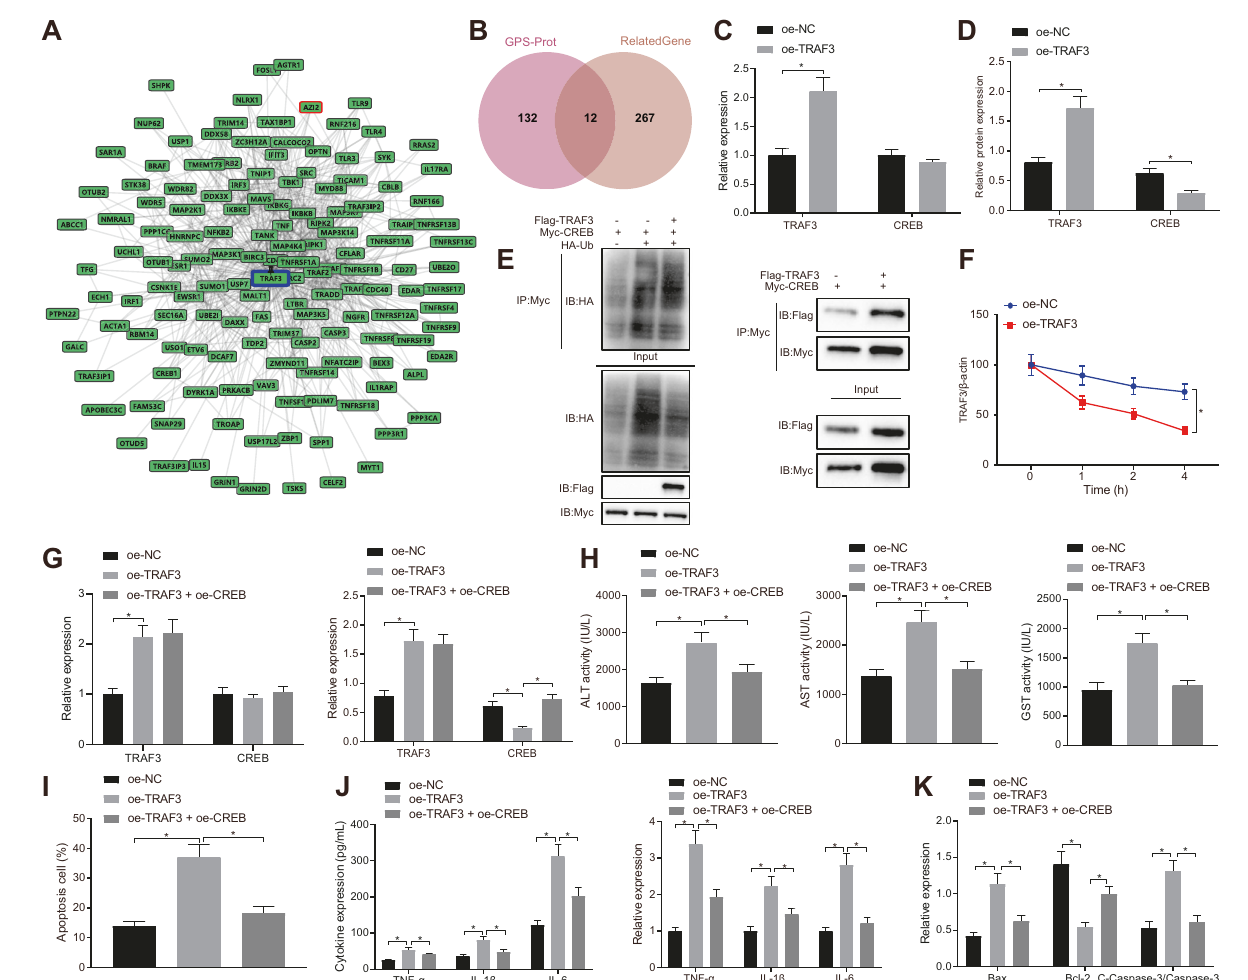
Fig. 4 TRAF3 attenuates the expression of CREB through ubiquitination, thus promoting the H 2 O 2 -induced hepatocyte apoptosis and release of in fl ammatory factors. A The GPS-Prot interaction network of TRAF3 in the GeneCards database. B The Venn map of the 12 intersecting genes interacted with TRAF and related to hepatic I/R injury. C The mRNA expression of TRAF3 and CREB in the presence of oe- TRAF3 or oe-TRAF3 + oe-CREB detected by RT-qPCR. D The protein expression of TRAF3 and CREB in the presence of oe-TRAF3 or oe-TRAF3 + oe-CREB detected by Western blot analysis. E The effects of TRAF3 on CREB ubiquitination detected by IP assay. F The effects of TRAF3 on CREB protein stability after CHX intervention. G The expression of CREB and TRAF3 in hepatocytes in the presence of oe-TRAF3 or oe-TRAF3 + oe-CREB detected by RT-qPCR and Western blot analysis. H Serum levels of GST, ALT, and AST in hepatocyte supernatant in the presence of oe- TRAF3 or oe-TRAF3 + oe-CREB detected by ELISA. I Hepatocyte apoptosis in the presence of oe-TRAF3 or oe-TRAF3 + oe-CREB detected by fl ow cytometry. J The expression of TNF- α , IL-1 β , and IL-6 in hepatocyte supernatant and hepatocytes in the presence of oe-TRAF3 or oe- TRAF3 + oe-CREB detected by ELISA and RT-qPCR. K The protein expression of Bax, Bcl-2, and cleaved-caspase-3 in hepatocytes in the presence of oe-TRAF3 or oe-TRAF3 + oe-CREB detected by Western blot analysis. * p < 0.05. The cell experiment was repeated three times. elevated upon SEV + miR-124-3p inhibitor treatment in H 2 O 2 - treated hepatocytes, which was then abrogated in the presence of SEV + miR-124-3p inhibitor + oe-CREB (Fig. 5D, E). Subsequently, Western blot analysis results showed that in presence of H 2 O 2 treatment, SEV + miR-124-3p inhibitor contributed to increased expression of cleaved-caspase-3 and Bax and decreased expres- sion of Bcl-2, while opposite trends were noted in H 2 O 2 -treated hepatocytes treated with SEV + miR-124-3p inhibitor + oe-CREB (Fig. 5F and Supplementary Fig. 1I). SEV manipulates miR-124-3p/TRAF3/CREB axis to alleviate the hepatic I/R injury in mice It was found that compared with sham-operated mice, miR-124-3p and CREB expressions were signi fi cantly diminished in liver tissues of I/R mice in addition to increased expression of TRAF3, which was reversed by SEV treatment. SEV + sh-CREB enhanced CREB expression in contrast to SEV + sh-control (Fig. 6A). ELISA data